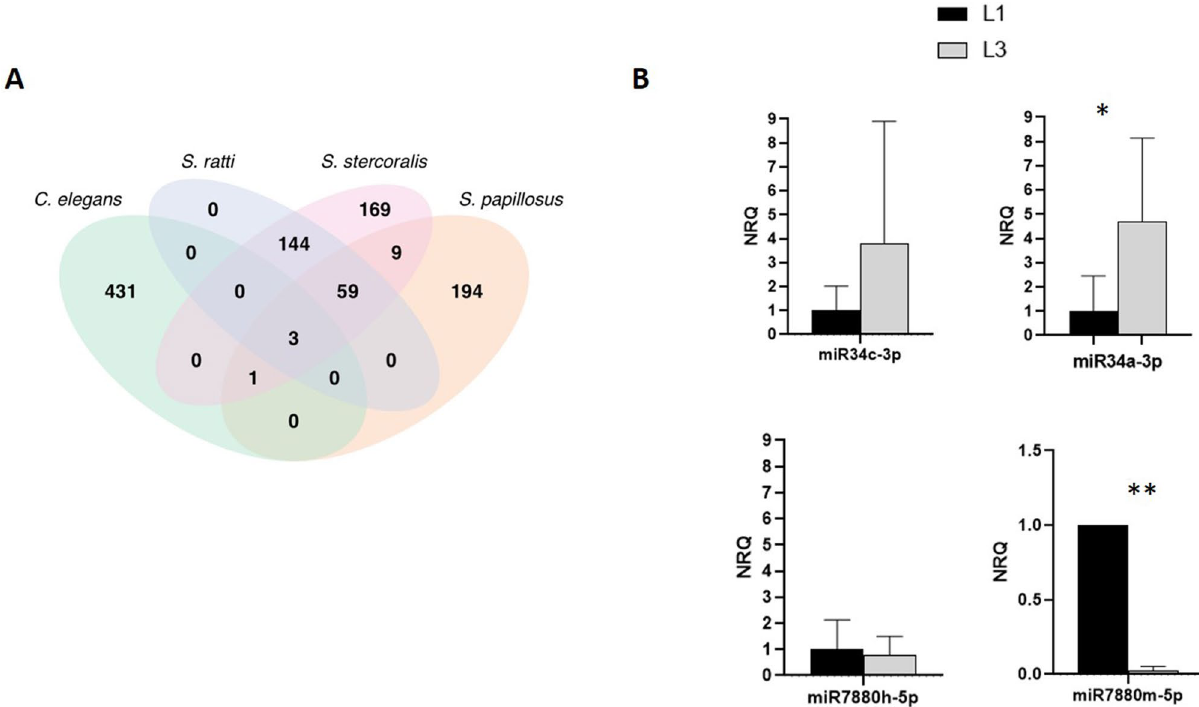
Figure 1. miRNAs identification for S. stercoralis . ( A ) Known and novel miRNAs were identified in S. stercoralis compared to S. ratti, S. papillosus and C. elegans . ( B ) RT-qPCR was used to verify the expression and modulation of miRNAs between L1 and iL3. Data are expressed as NRQ. For the comparison analysis, L1 expression value of each miRNA was set equal to 1. P value < 0.05*; <